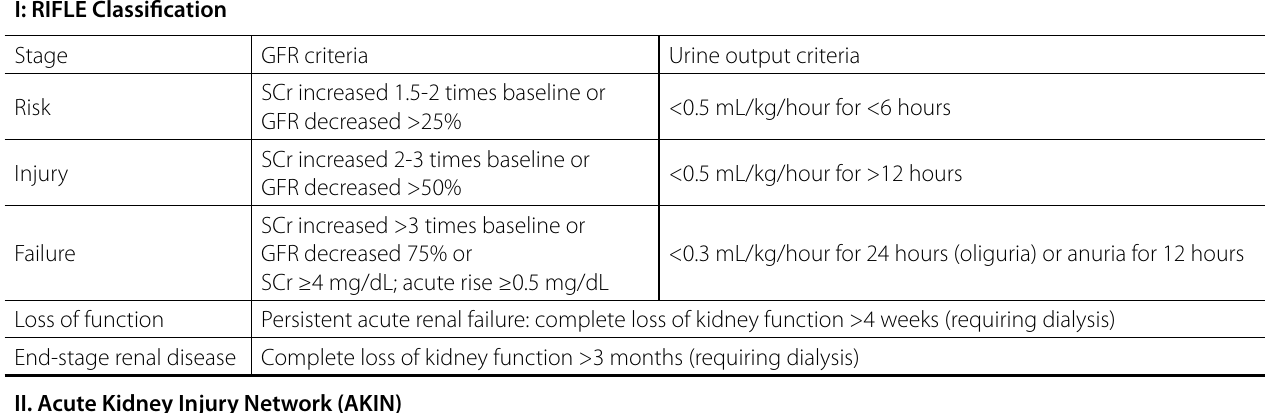
Table 1 . Classification systems for acute kidney